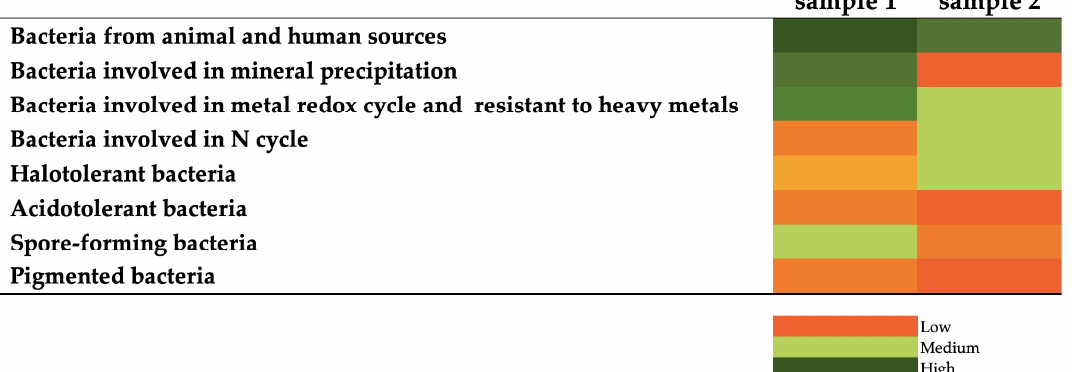
Figure 7. Heatmap representing the main features of the biofilm communities inhabiting the coating